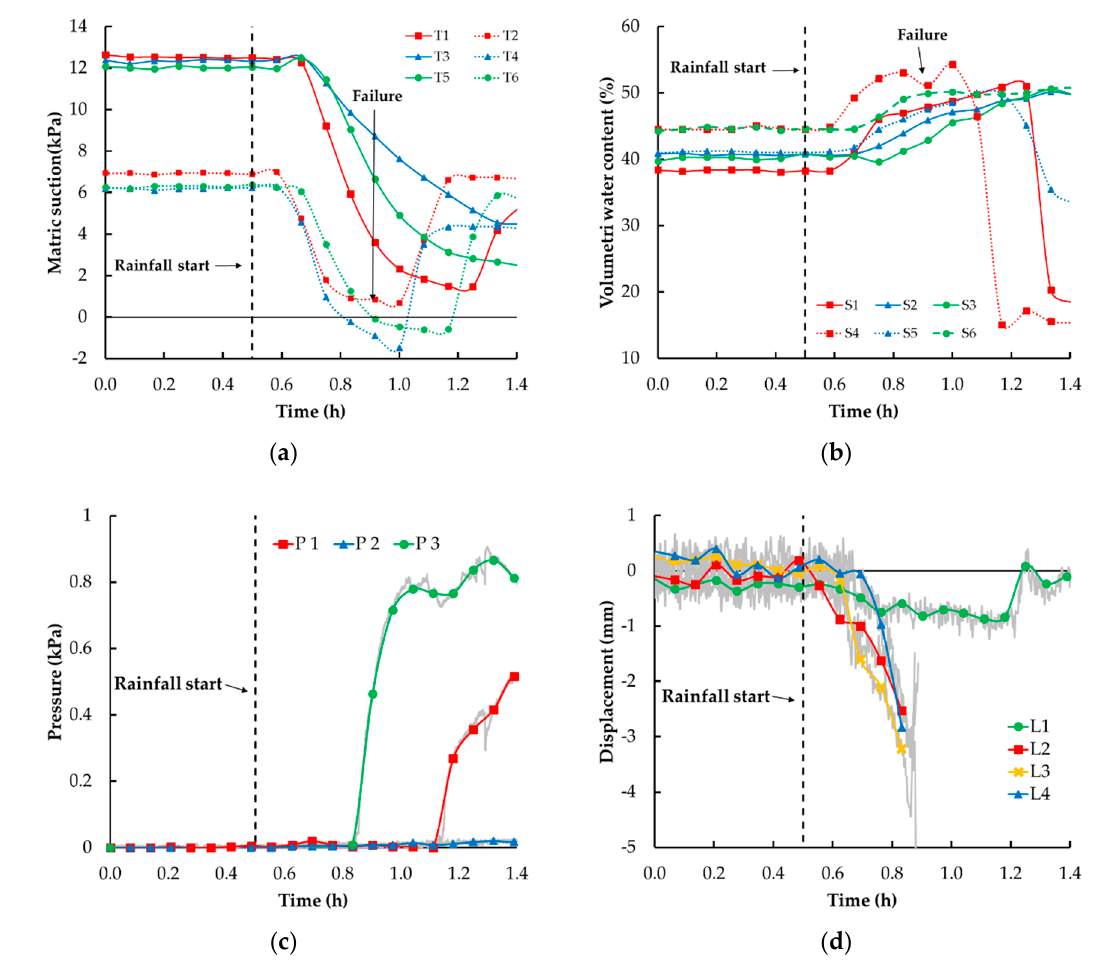
Figure 14. Parameters graphs monitored during the infiltration phase in a sloping deposit: ( a ) suction; ( b ) volumetric water content; ( c ) pore water pressure at the bottom of flume; and ( d ) orthogonal displacements by the soil surface.